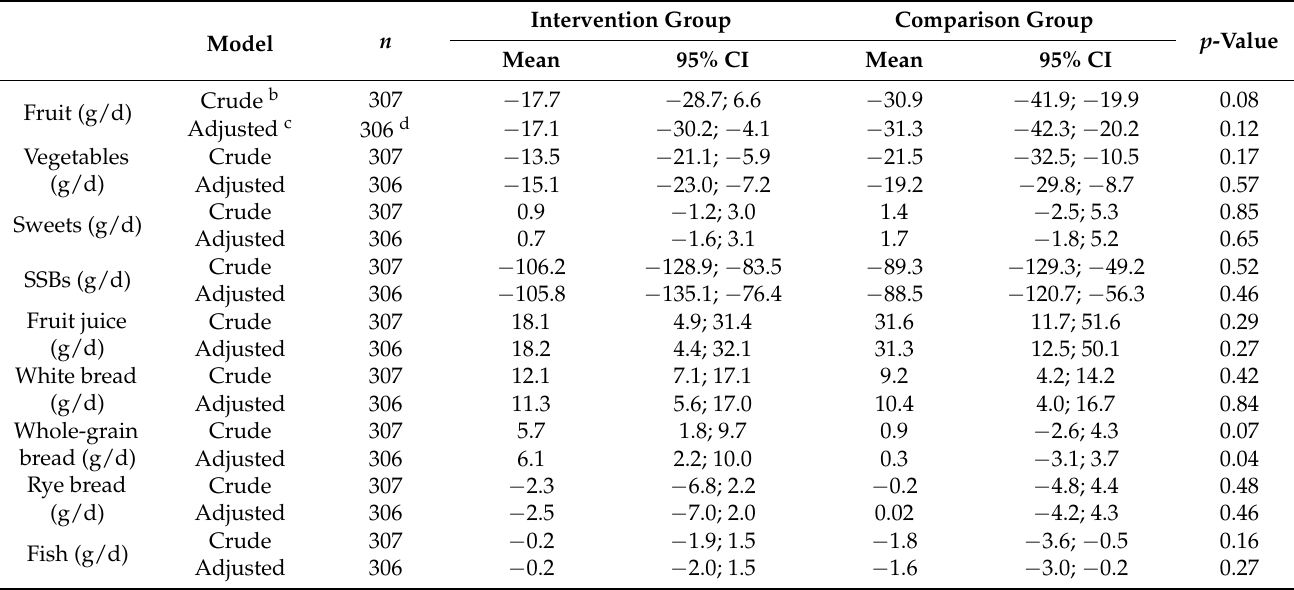
Table 3. Effects (changes between pre- and post-intervention) of the intervention on intake of foods and beverages (g/d) in the intervention and in the comparison group a .